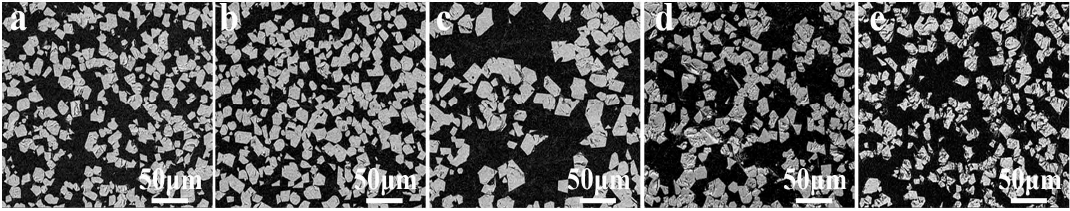
Figure 7. SEM images of cooled samples at various air flow rate. ( a – e ) show 140, 155, 170, 185 and 200 mL/min, respectively.